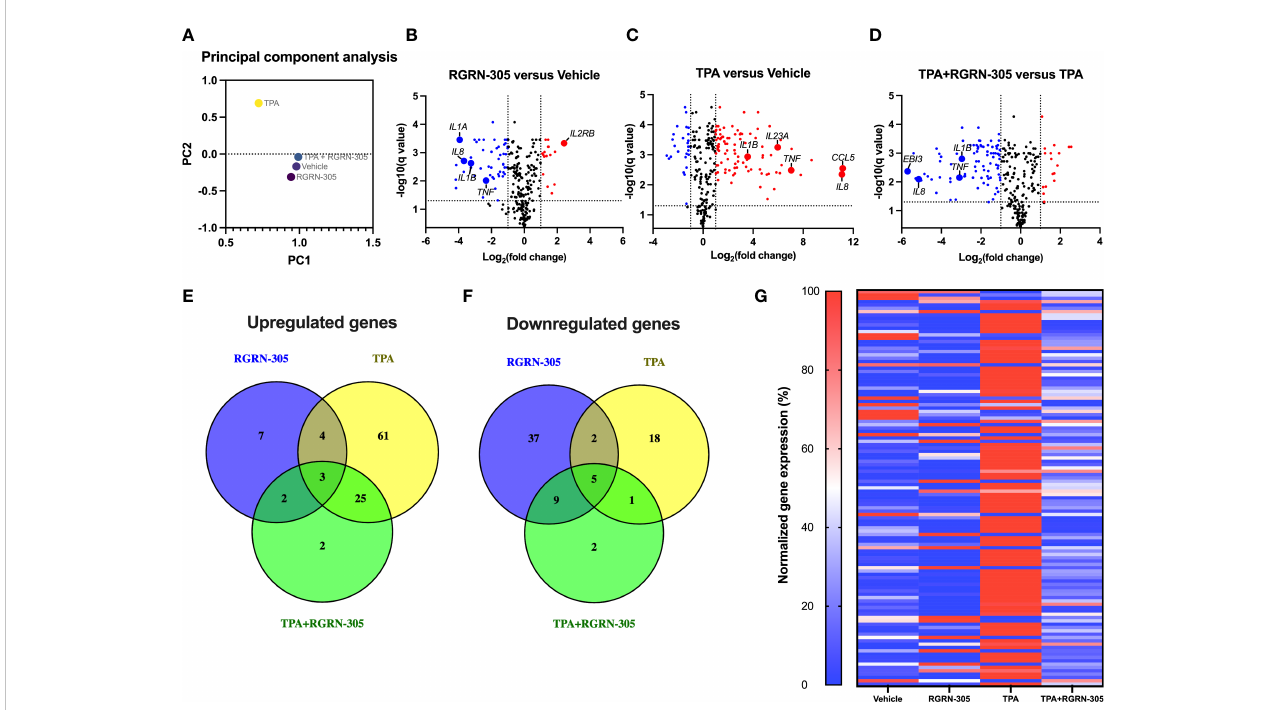
FIGURE 1 Nanostring nCounter gene expression analysis. Primary human keratinocytes were preincubated with RGRN-305 (5 µM) for 8 hours before stimulation with TPA (100 nM) for 8 hours (n = 6). (A) Principal-component analysis (PCA) of the cultured human keratinocytes. (B – D) Volcano plots showing log 2 fold change (x-axis) and q-values (y-axis) comparing the different treatment groups: RGRN-305 versus vehicle (B) TPA versus vehicle (C) and TPA +RGRN-305 versus TPA (D) . The dashed horizontal lines indicate a q-value of 0.05, while the vertical lines mark a log 2 fold change of 1. Red dots represent upregulated differentially expressed genes (DEGs), whereas blue dots represent downregulated DEGs. (E, F) Venn diagrams depicting overlapping upregulated (E) and downregulated (F) DEGs. (G) Heatmap of DEGs upon TPA stimulation. Gene expression was normalized to a scale ranging between 0 and 100%. The smallest and largest values of normalized gene counts across all samples for a given gene were de fi ned as 0 and 100%, respectively. DEGs were de fi ned as at least 1 log 2 fold change and q-value < 0.05. DEG, differentially expressed gene. TPA, 12-O-